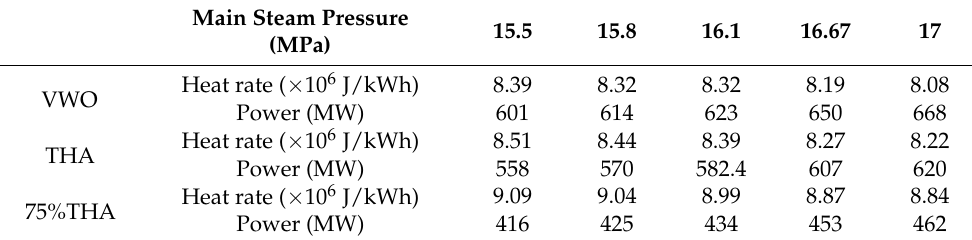
Table 3. Effect of different main steam pressure on heat rate and power.